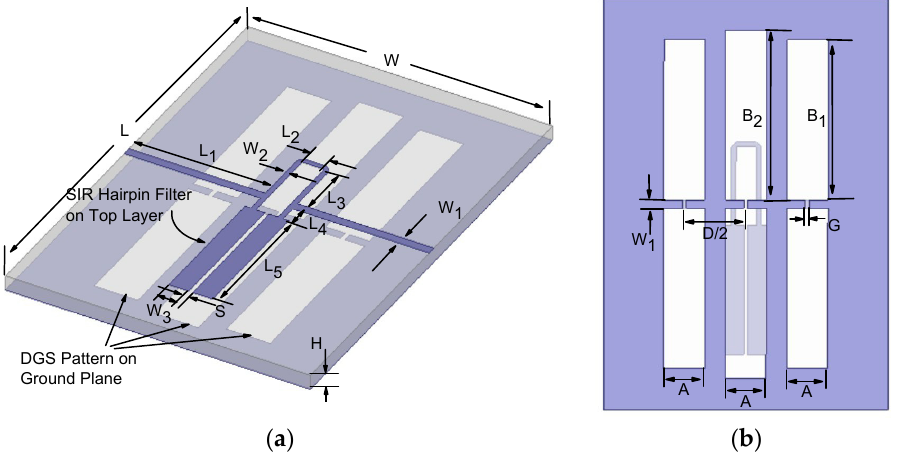
Figure 7. LPF model based on SIR and DGS. ( a ) 3-D model diagram and ( b ) DGS pattern diagram on the backside of the proposed filter.